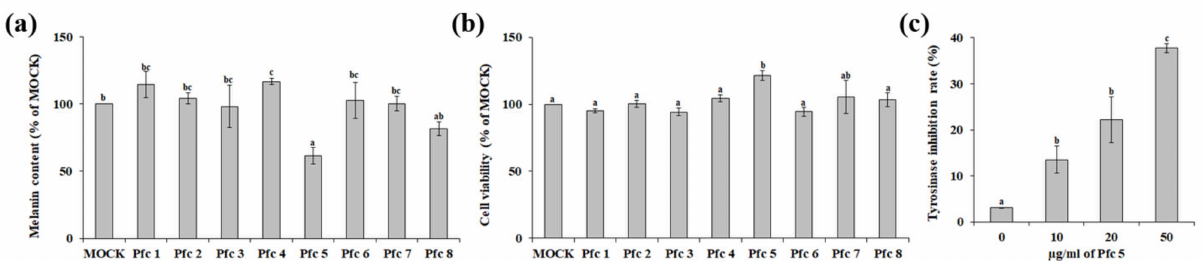
Figure 2. Comparison of antimelanogenic activity among Perilla frutescens var. crispa genotypes. ( a ) The effect of extracts obtained from eight genotypes on melanin production was analyzed in α -MSH/IBMX-stimulated B16F10 cells. ( b ) The effect of each extract on the viability of B16F10 cells. ( c ) Inhibitory effect of Pfc 5 on tyrosinase activity. The mean of three independent experiments is plotted with SE. Different letters indicate significant differences among the groups ( p <